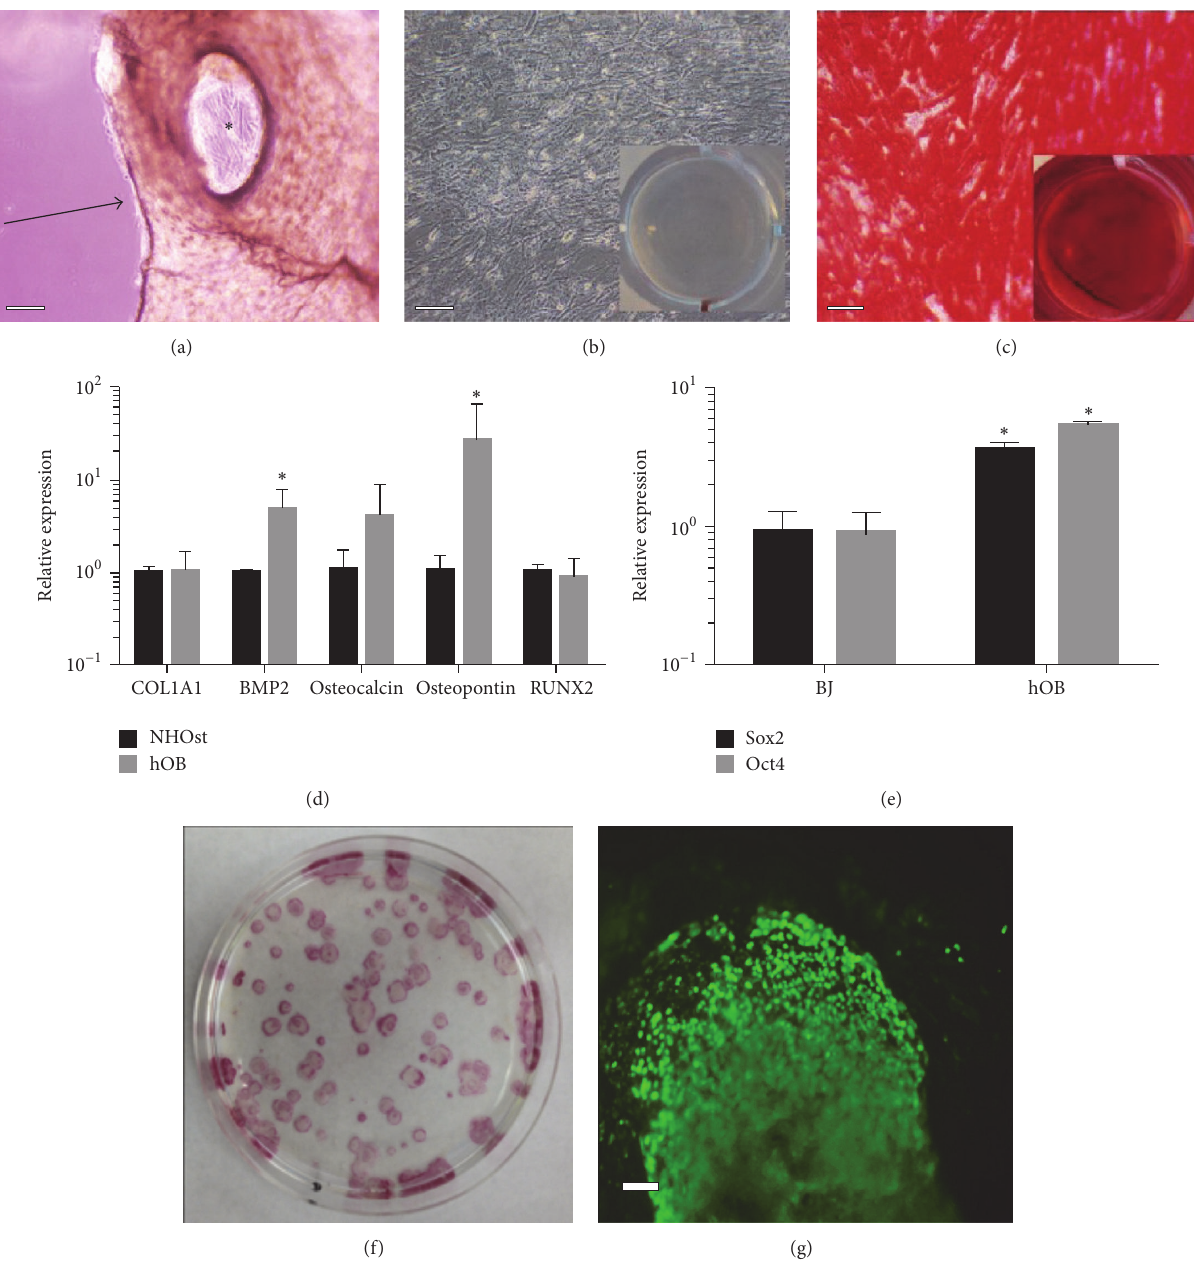
Figure 1: Characterization and reprogramming of donor-derived osteoblasts. (a) Example of donor bone chip in media (arrow) with osteoblasts emerging onto culture flask (asterisk). Osteoblasts were cultured in growth (b) or osteogenic induction media (c) and the resulting calcium deposits were stained with Alizarin Red S and imaged (scale bars = 30 𝜇 m and inserts are at 1x). (d) The donor-derived osteoblasts were assayed with qRT-PCR for osteoblast markers, osteocalcin, osteopontin, RUNX2, BMP2, and COL1A1 and compared to a commercially available osteoblast cell line (NHOst). (e) qRT-PCR analysis of pluripotent gene expression, Sox2 and Oct4, in the hOBs compared to neonatal BJ fibroblasts. ( ∗ 𝑃 < 0.05 ). (f) Alkaline phosphatase staining of primary reprogramming plate of hOB-iPSC. (g)